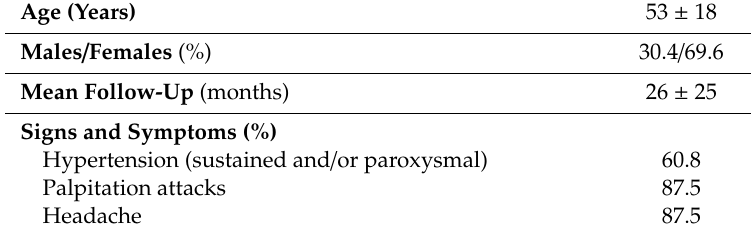
Table 1. Baseline demographic and anthropometric data. Total ( n =